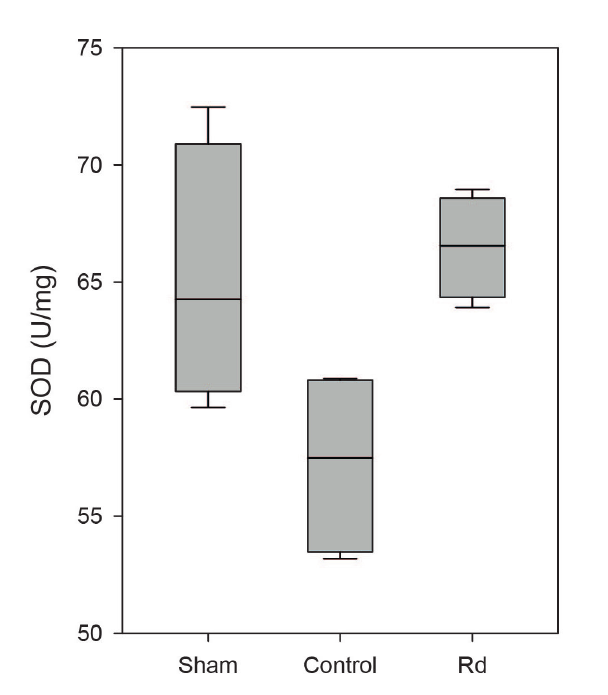
Fig. 4B - Boxplot of superoxide dismutase (SOD) activity in each group. SOD activity was significantly higher in the Rd group than in the control group (P=0.029). There was no significant difference in SOD activity between the sham and Rd groups (P>0.05).